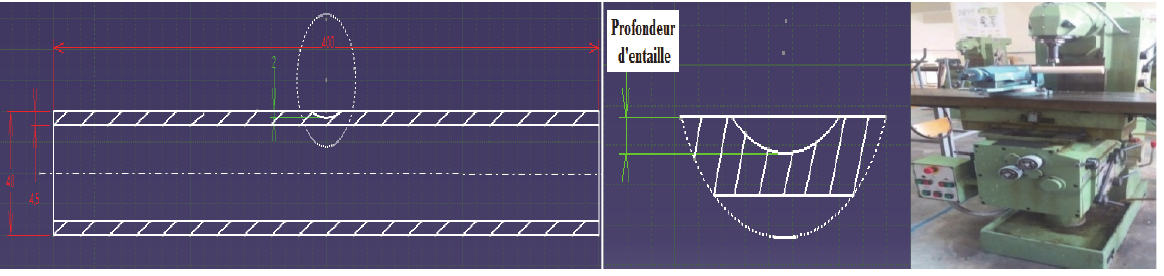
Figure 1: CPVC notched